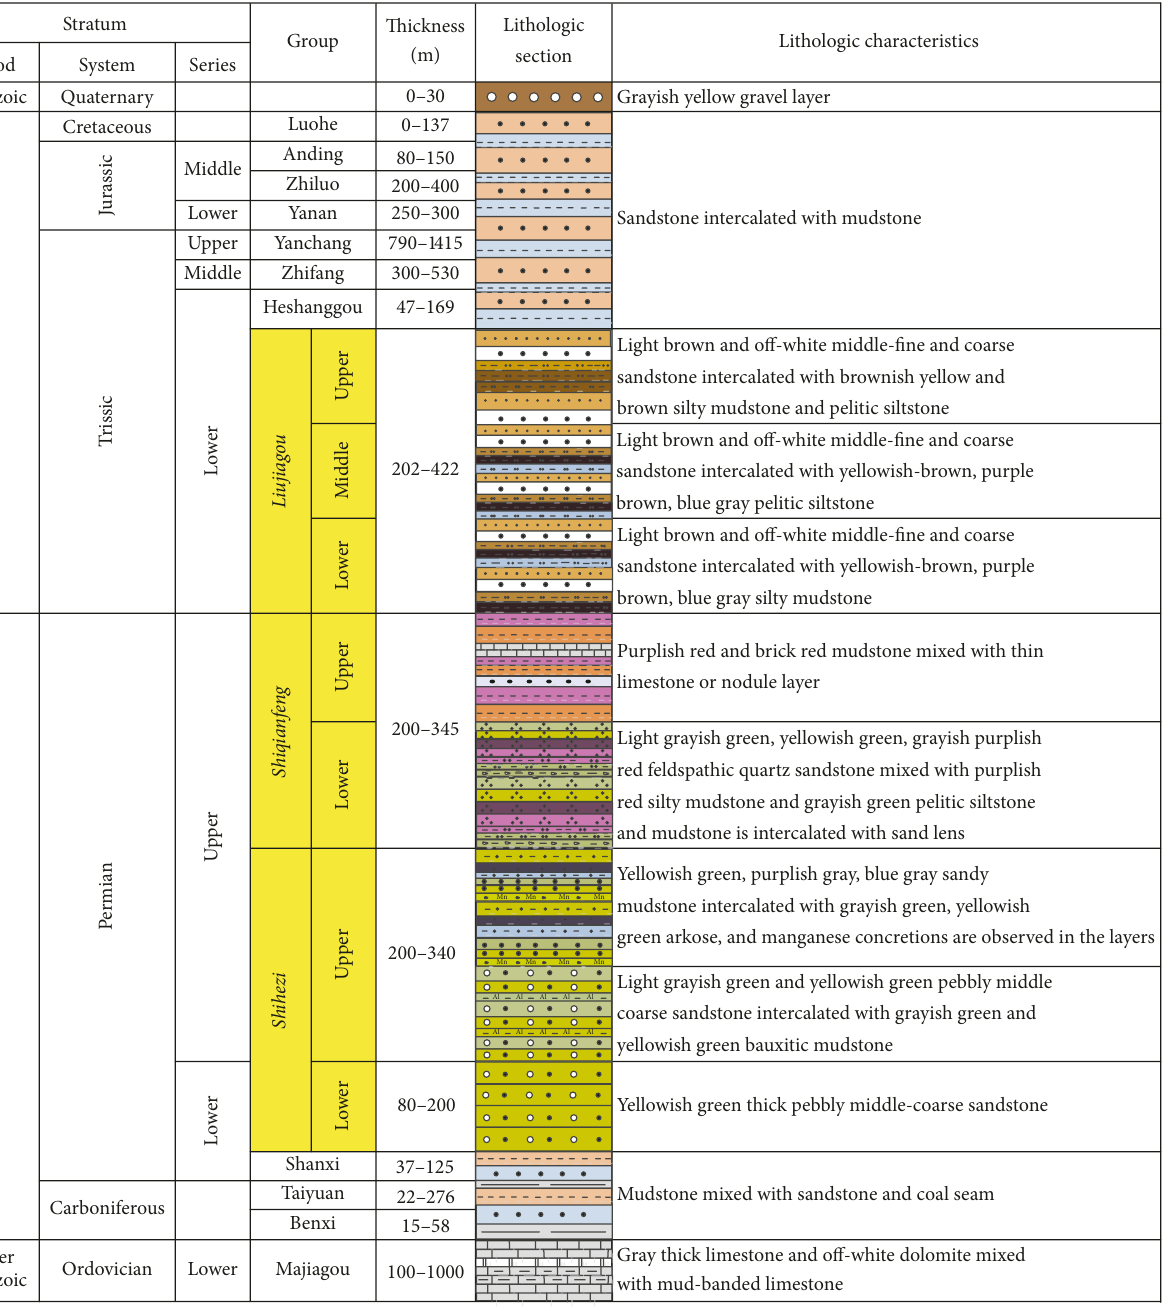
Figure 1: Lithologic and stratigraphic sequence of the Ordos Basin, illustrating the positions and geological characteristics of the main injection formations (modified from Li et al.